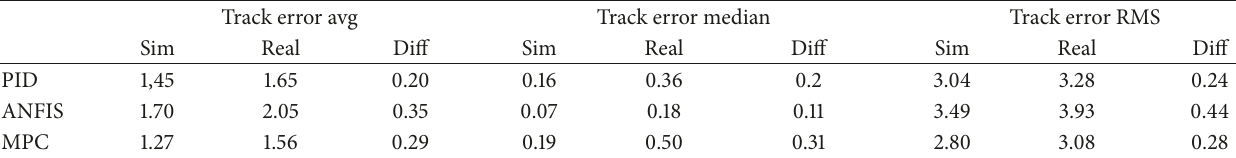
Table 7: Tracking errors [Km/h].